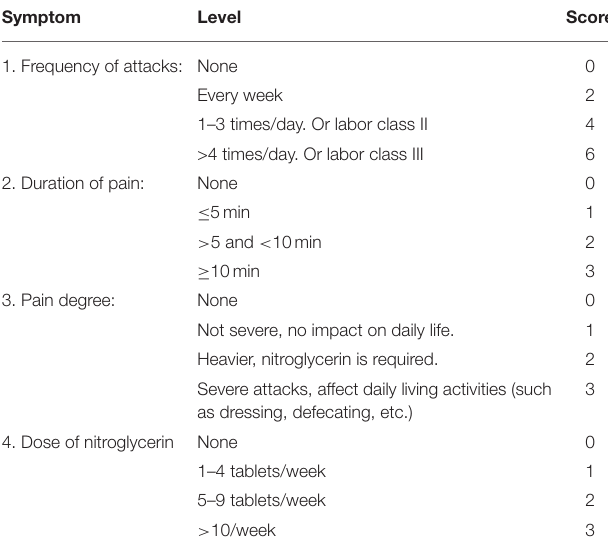
TABLE 2 | Angina pectoris symptom